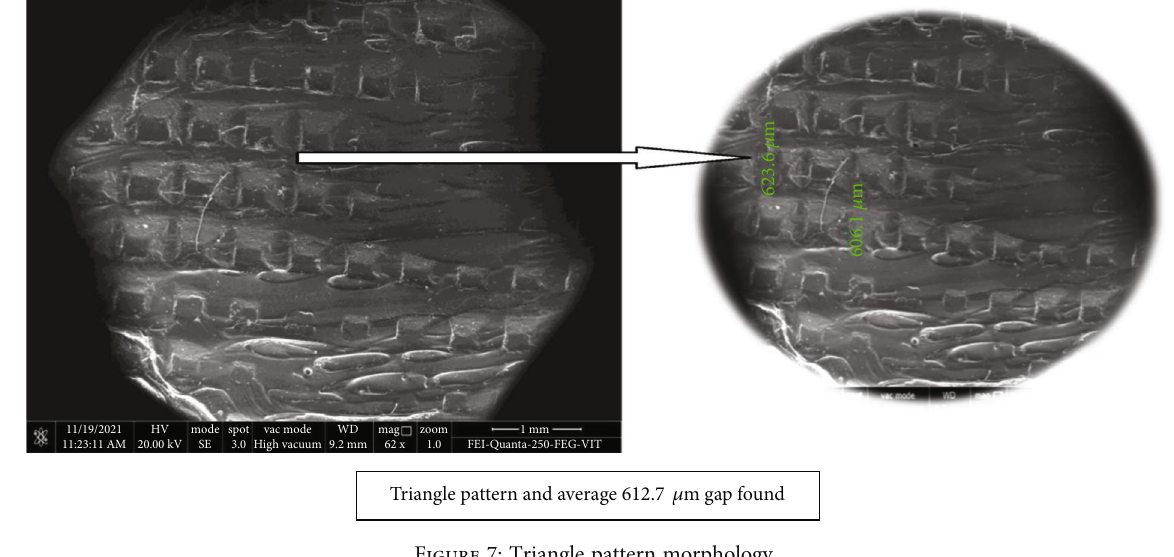
Figure 7: Triangle pattern morphology.